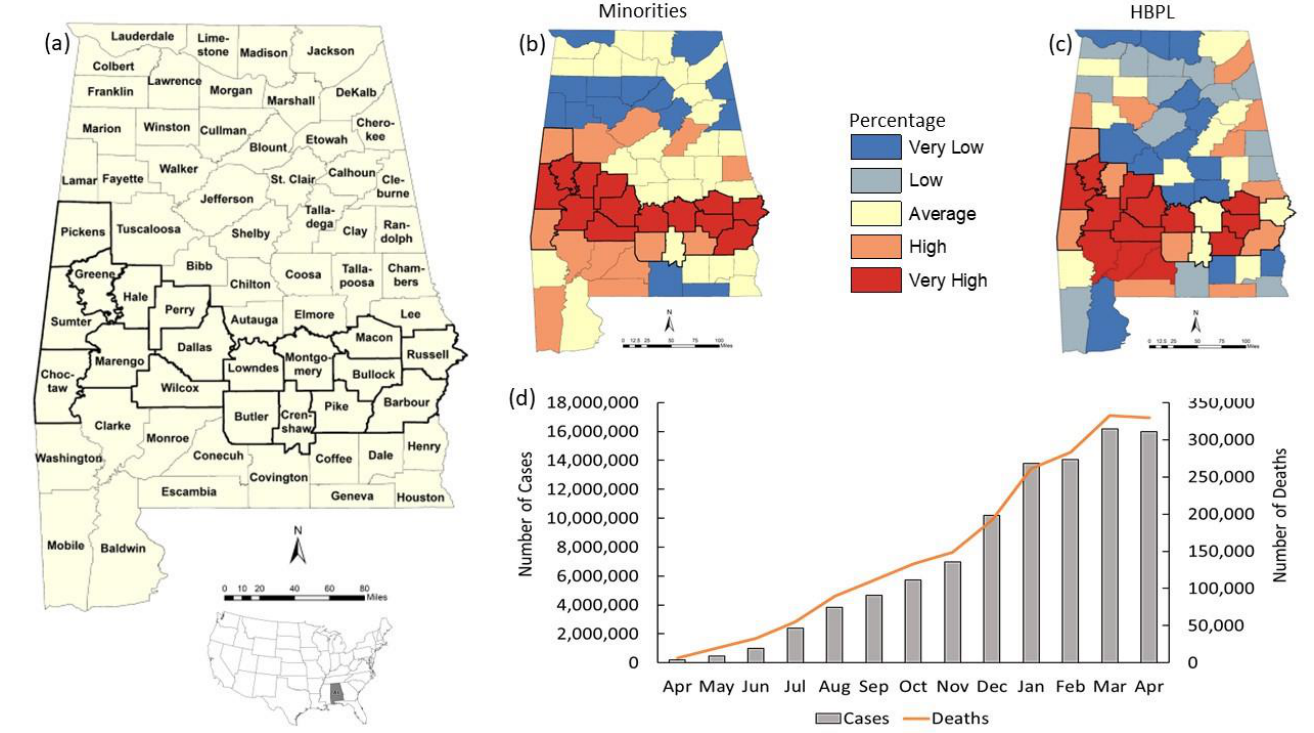
Figure 1. The study area: ( a ) location of the State of Alabama; ( b ) percentage of minority population in Alabama counties; ( c ) percentage of the number of households with income below poverty level for each county; ( d ) the number of COVID-19 cases (grey bars) and deaths (red line) between April 2020 and April 2021. The thick black lines in the maps indicate the boundaries of Black Belt counties.